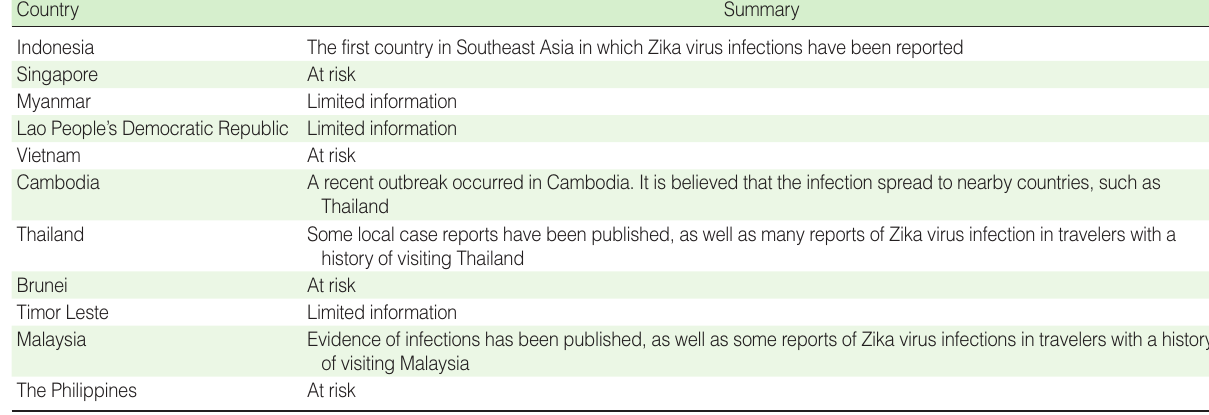
Table 1. Summary of important points for each country in Southeast Asia Country Summary